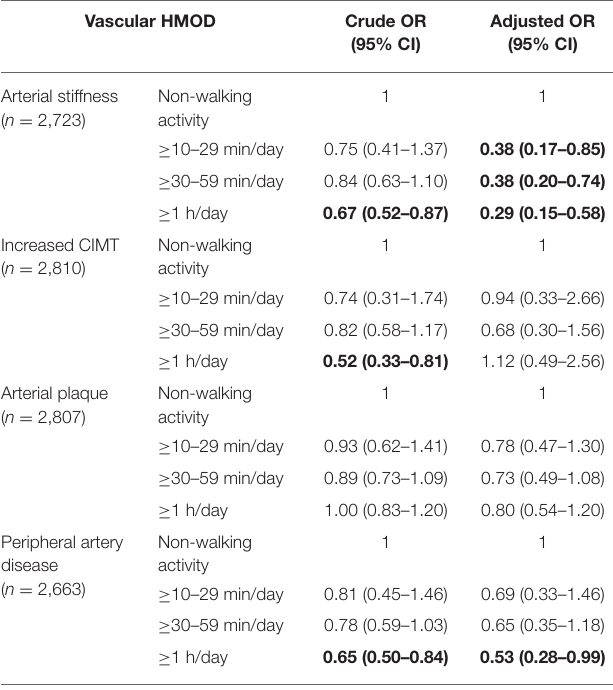
Bold values indicate significant results (P < 0.05). Multivariate logistic regressions were performed to investigate the risk of vascular HMOD across different walking duration without and with adjustment for walking days per week, together with cardiovascular risk factors (including age, gender, smokers, body mass index, systolic blood pressure) and concomitant diseases (hypertension, diabetes mellitus, coronary heart disease). CIMT,carotidintima–mediathickness;HMOD,hypertensivemediatedorgandamage;OR, odds ratio.